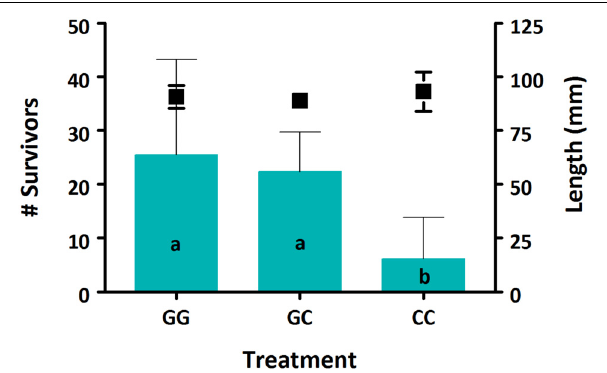
FIGURE 1 | Survival (bars) and growth (markers) of sablefish larvae from each treatment. Data are presented as means ( ± SD). Different lowercase letters denote significant differences between treatments. Where there are no letters, no significance was found. A significant effect of treatment was seen on sablefish survival ( p = 0.016) but not on length ( p > 0.05).